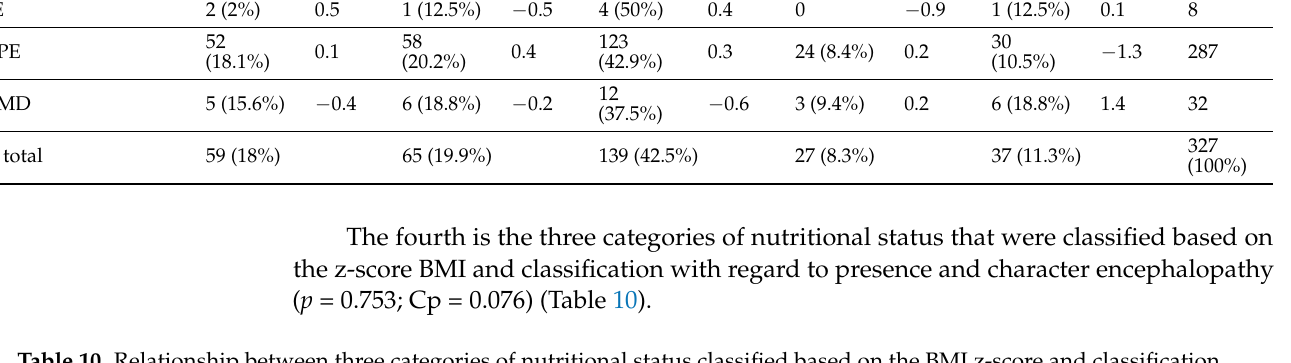
Table 10. Relationship between three categories of nutritional status classified based on the BMI z-score and classification with regard to presence and character